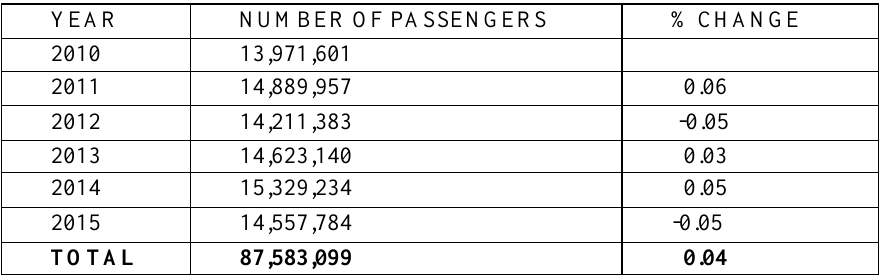
Table 4. Total air passenger movement in